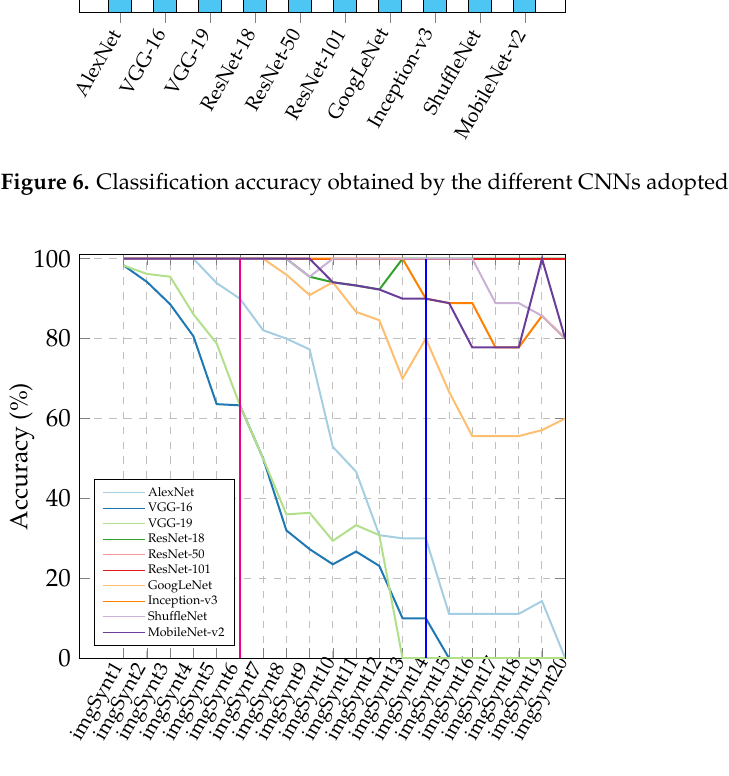
Figure 7. CNNs’ accuracy trend when increasing the number of WBC inside the image. In particular, the x-axis values start with imgSynt1 that represent the synthetic test set with one WBC added and terminate with imgSynt20 , composed of twenty WBC